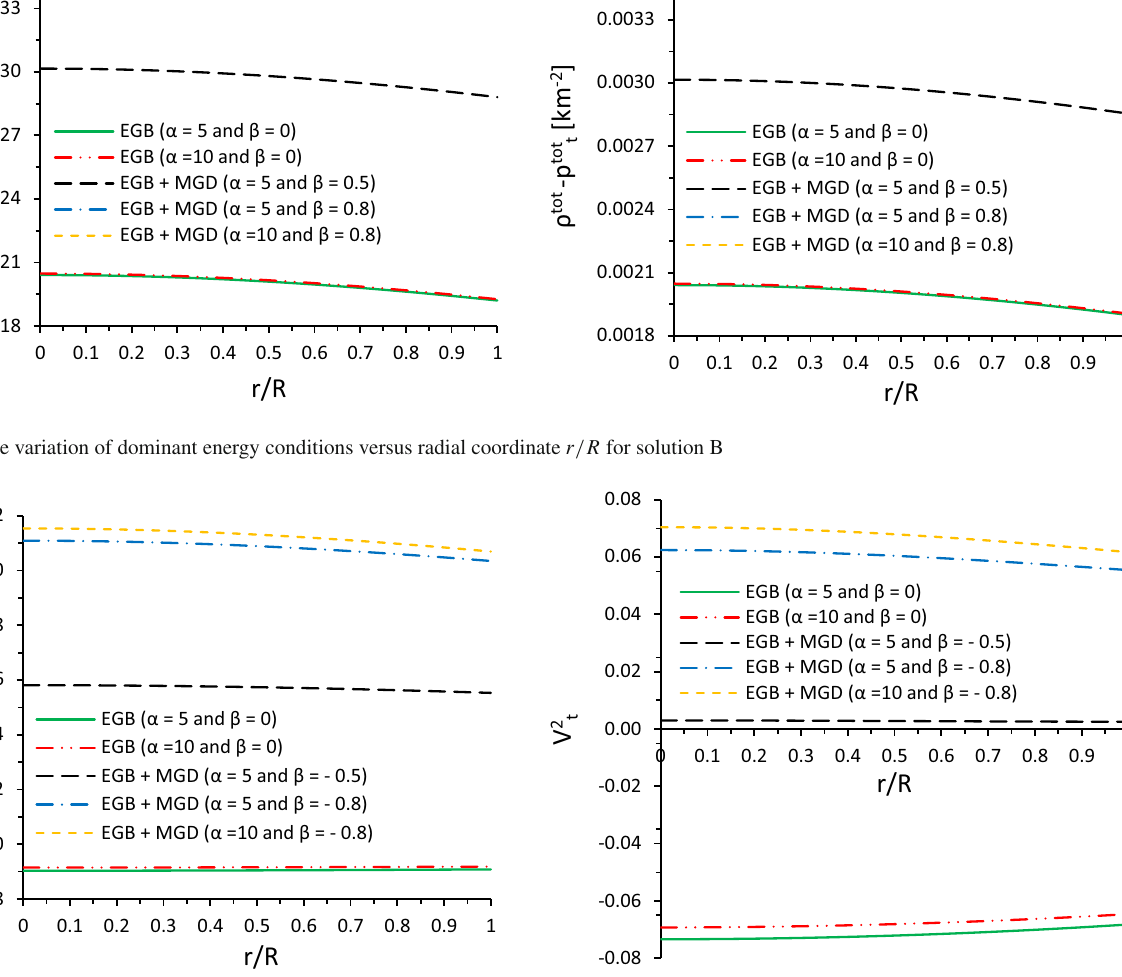
Fig. 9 The variation of sound speed versus radial coordinate r / R for solution